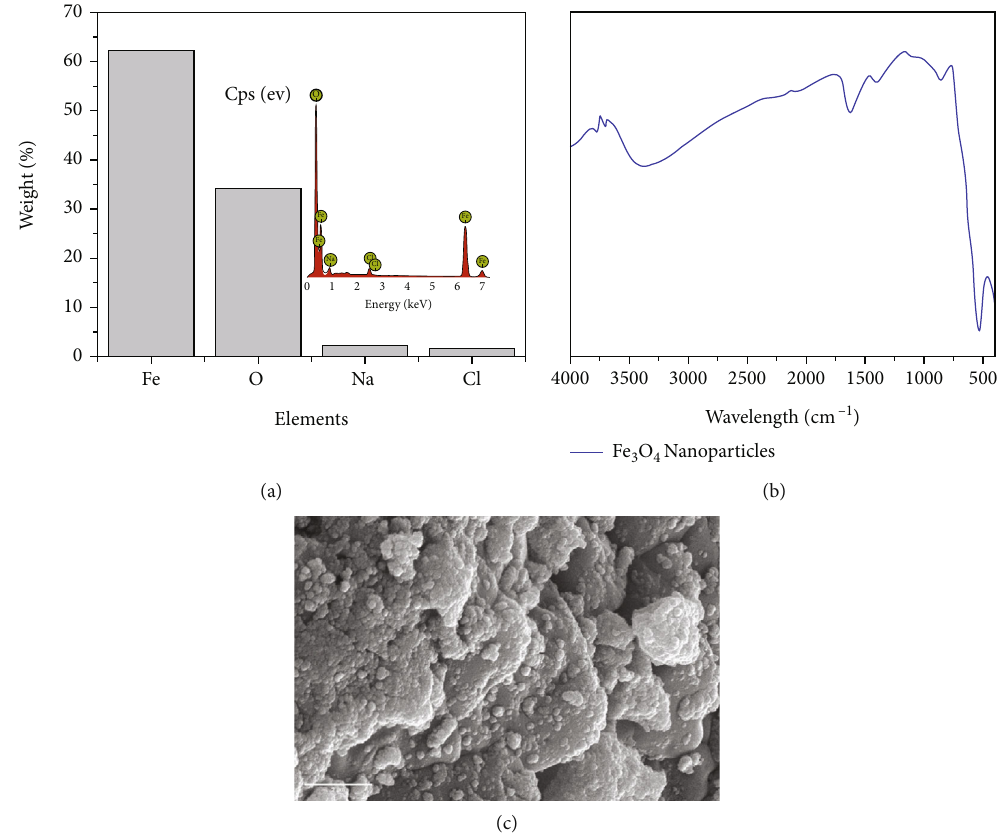
Figure 2: (a) EDX analysis of synthesized nanoparticles; (b) FTIR spectrum of synthesized nanoparticles; (c) micrograph of synthesized nanoparticles.